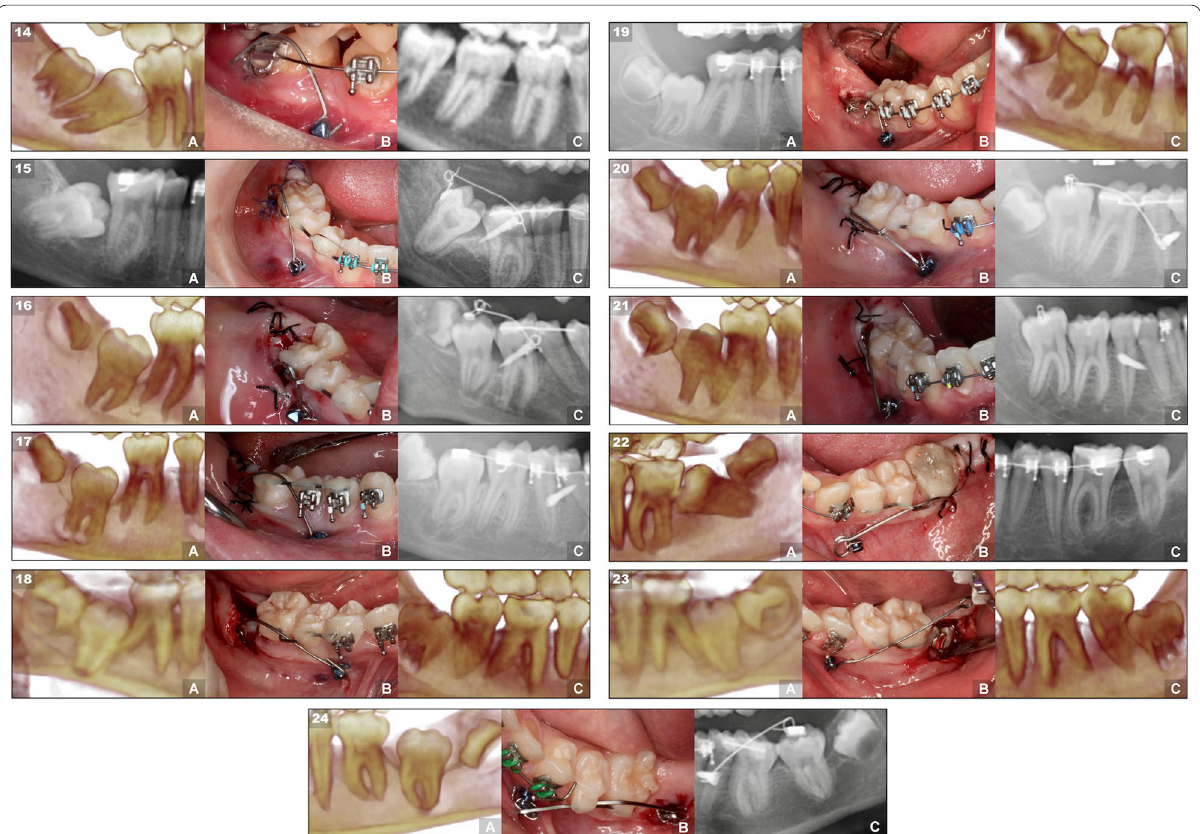
Fig. 5 Case series of mandibular M2s treated with the miniscrew‑supported pole technique. The 11 cases (from 14 to 24) are organized according to their angulation, from mesial to distal, showing first the rights and then the left ones. Each case is composed of three images that represent three moments during the treatment: a pretreatment radiograph showing the impacted or retained lower molar. b molar with the pole technique surgery carried out. c radiograph showing the final result with the molar in a correct position and